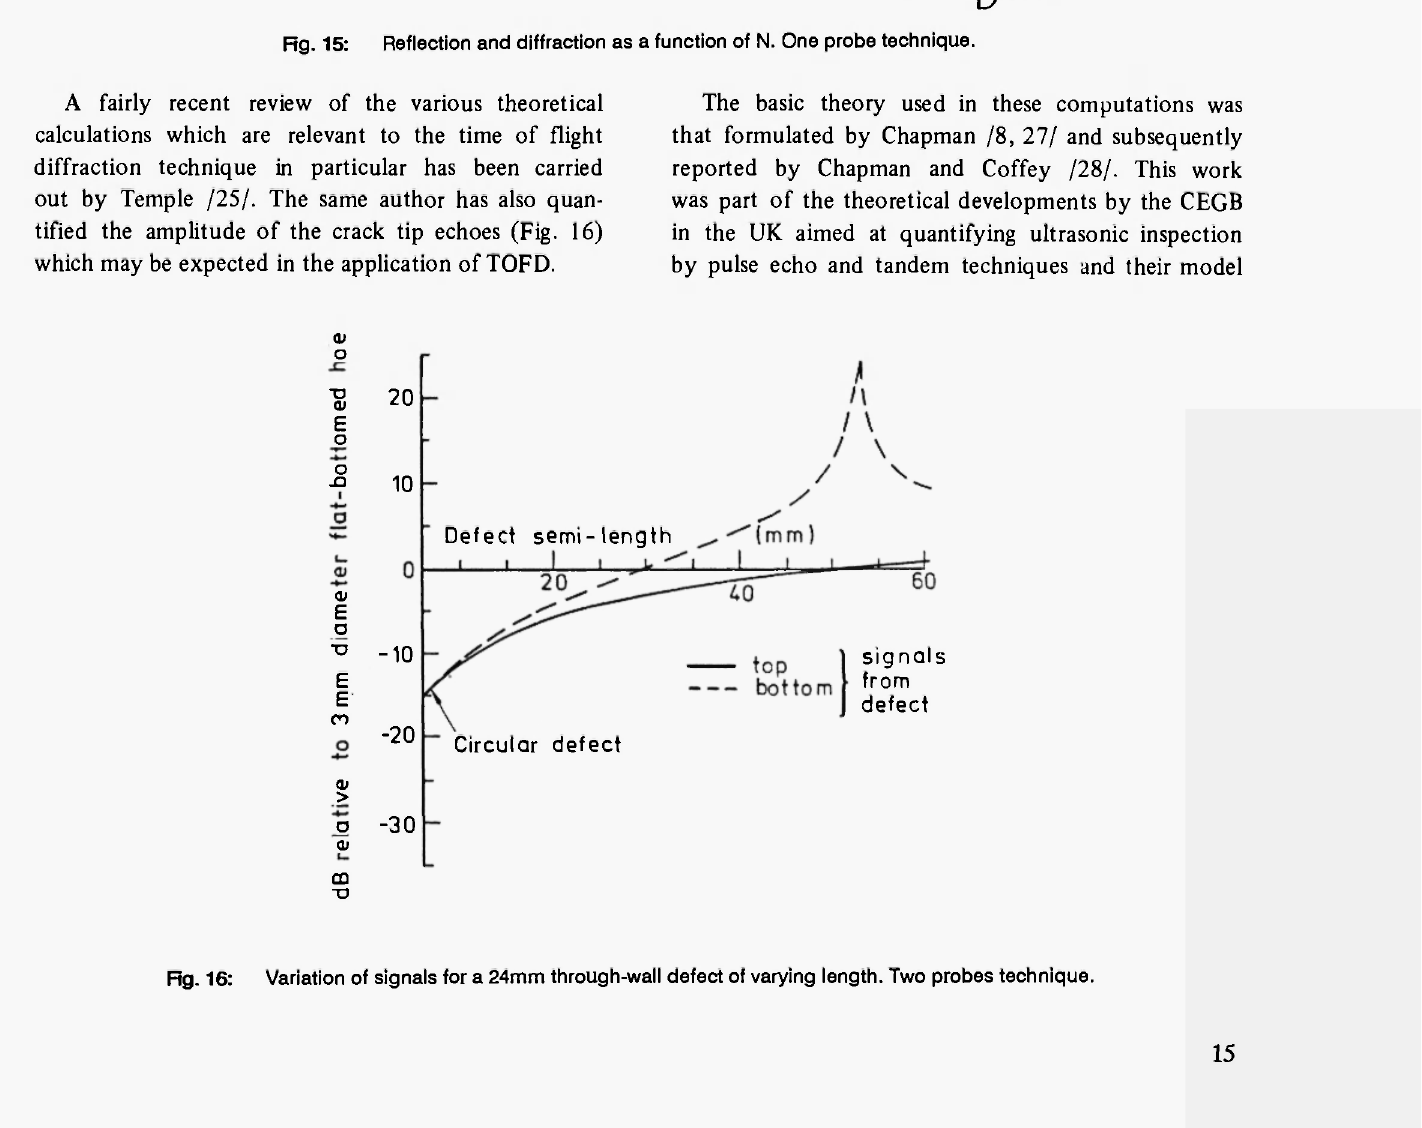
Circular defect